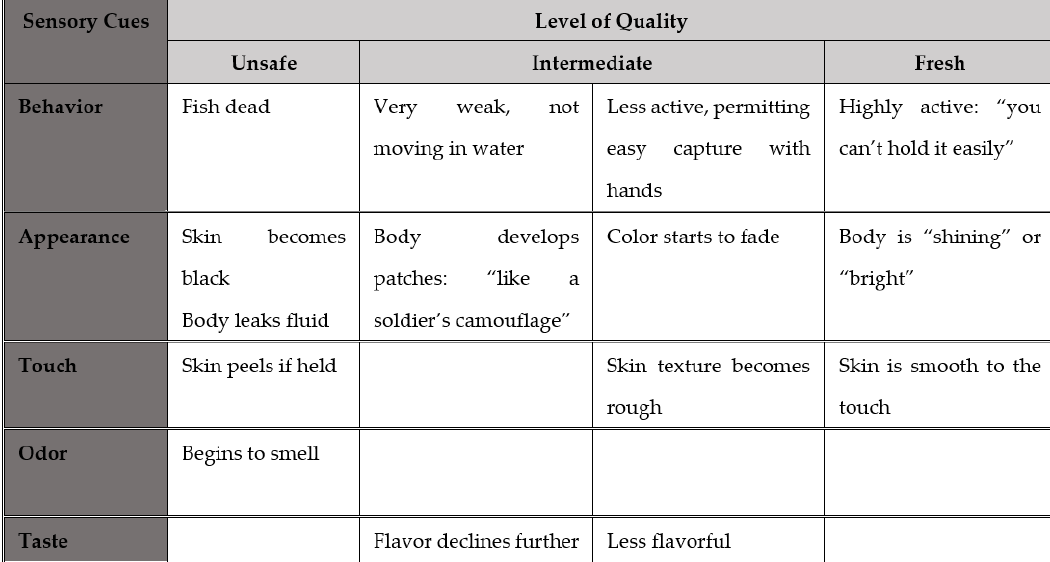
Figure 1. Vendors’ typology of fish quality.